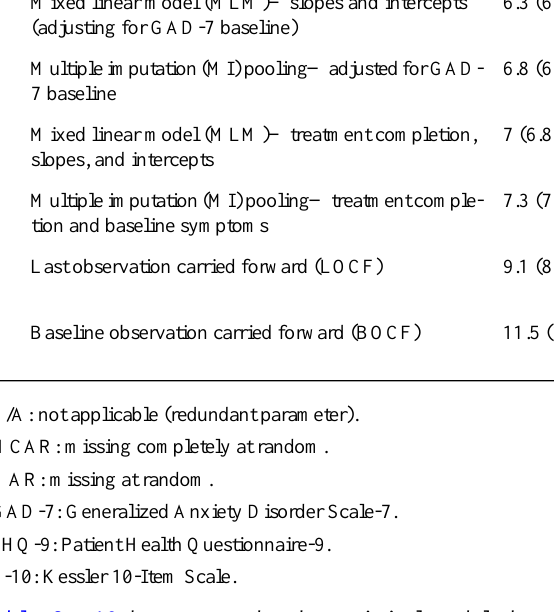
Adjusted models from alternative statistical methods (missingness and GAD-7